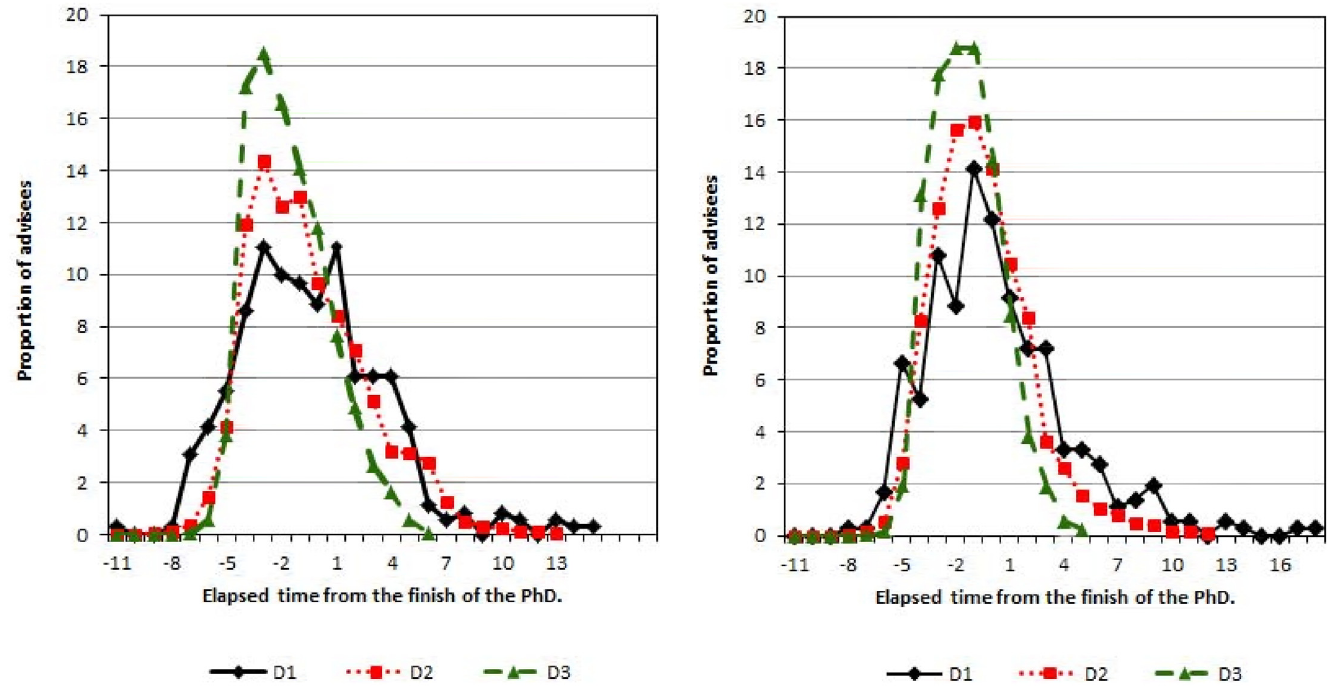
Fig 2. Distribution of the time to the first publication with and without the advisor ( z i and z (cid:4)